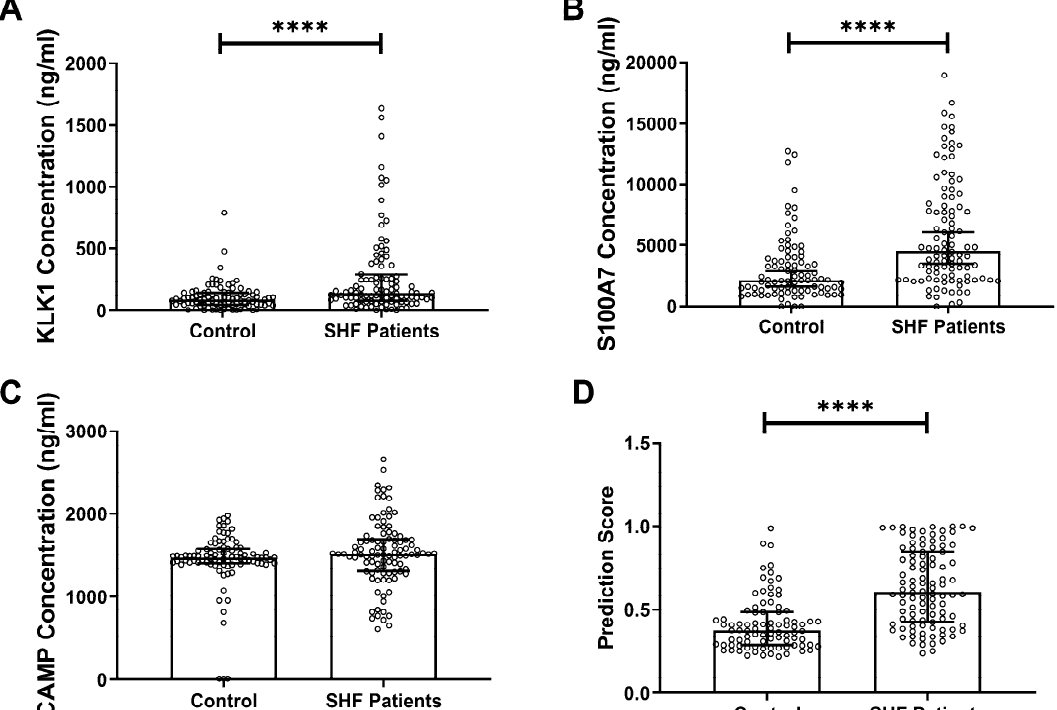
Figure 1. Individual concentrations of ( A ) KLK1, ( B ) S100A7, ( C ) CAMP in saliva samples collected from controls and systolic heart failure (SHF) patients, and ( D ) their combination, plotted on a scatter plot with box and error bars showing the median and 25–75th percentile. The Kruskal–Wallis test and Dunn’s multiple comparisons test were performed on unpaired data with non-normal distribution to compare values between multiple groups. Significant differences in the protein concentrations between patients with SHF and healthy controls are denoted by **** ( p < 0.0001).